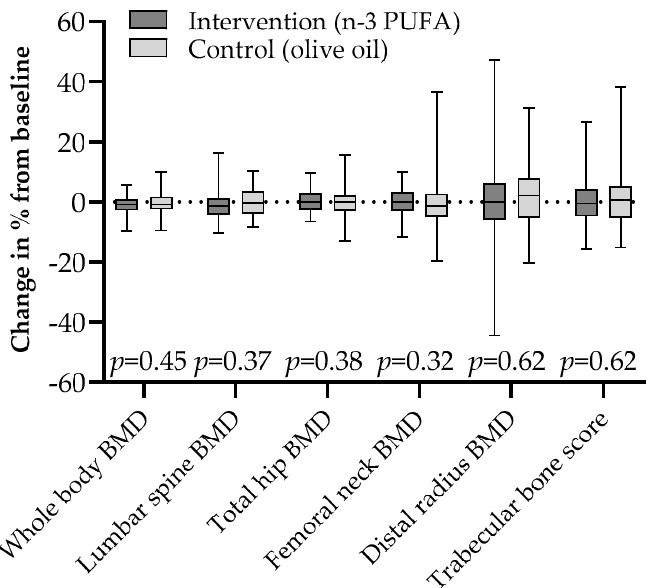
Figure 1. Changes in bone mineral density and trabecular bone score by intention to treat after 44 weeks of 2.6 g daily supplementation with marine n-3 polyunsaturated fatty acids or olive oil in adult kidney transplant recipients; median (line) with interquartile range (box) and full range (whiskers).